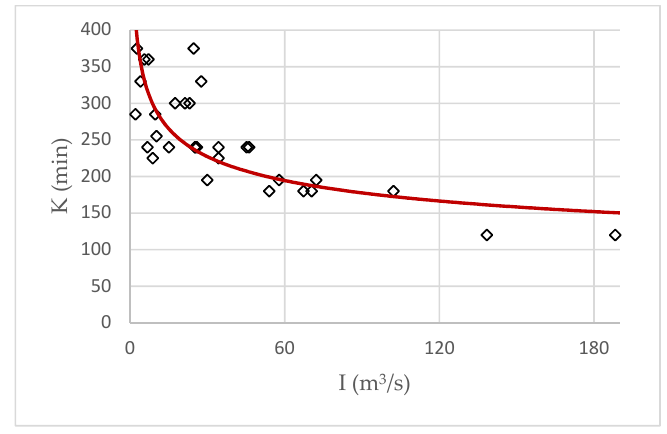
Figure 4 . Empirical estimation of K as a function of inflow values at the Campo gauge station.